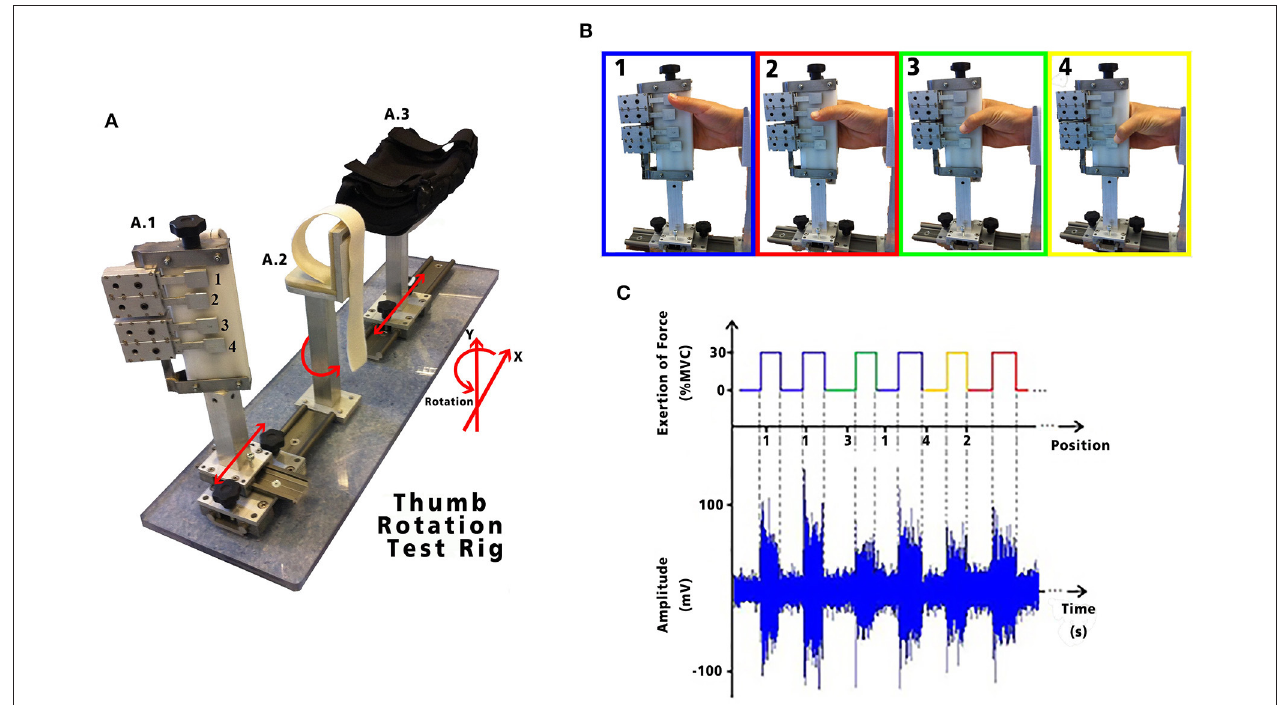
FIGURE 2 | (A) Test apparatus used to examine thumb opposition; (A.1) fingers holder: allows freedom of movement in the X and Y axis, as well as rotational movement with four strain gauges represented by the numbers 1, 2, 3, and 4. Each strain gauge corresponds to the 4 digits: secundus digitus manus, digitus medius, digitus annularis, and digitus minimus manus, respectively. Each LSR could be moved in the X and Y axis to allow adjustment to each subject’s anatomical measurements; (A.2) wrist holder: fixed padded holder that avoided any flexion/extension of the wrist, minimizing activity in the forearm; and (A.3) elbow holder: with movement in the X axis, to allow adjustment for subject comfort, minimizing muscle contractions caused by pronation, supination, flexion or extension of the forearm. HD-sEMG data acquired while performing the tasks are shown with its synchronous exertion of force. (B) Static thumb positions performed by each volunteer. (C) Exemplary sEMG signals from one channel of the HD-sEMG highlighting the different amplitudes for the different static